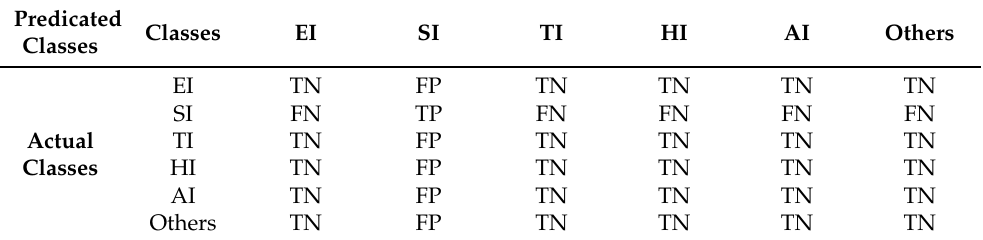
Table 5. Confusion matrix for multi-class classification for social issues (SI) class vs. other classes: Education issues (EI), Social issues (SI), Technology issues (TI), Health issues (HI), and Attitudes and Ethical issues